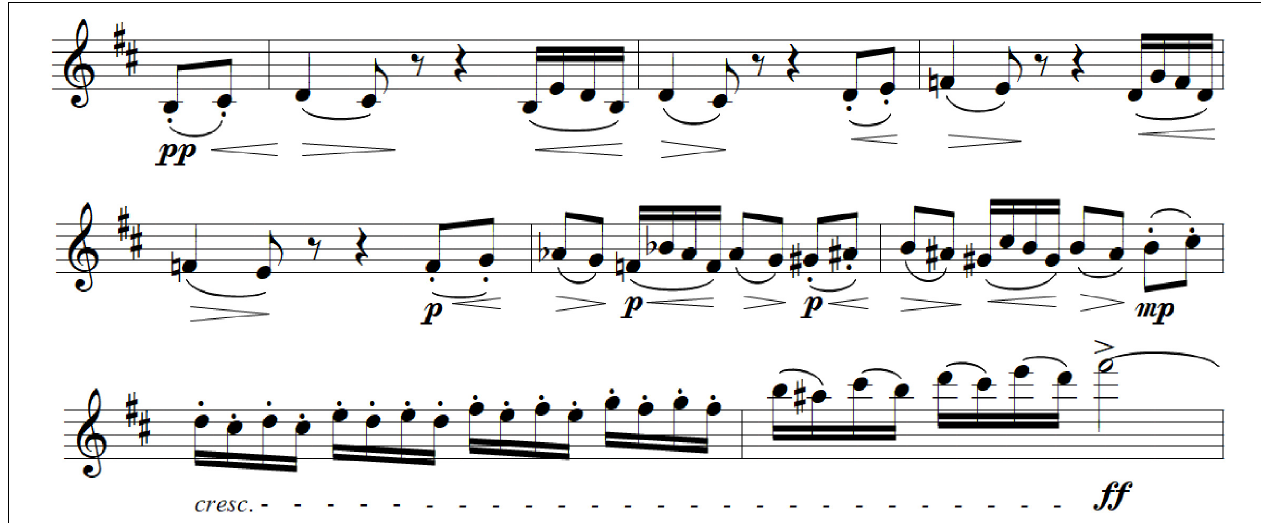
FIGURE 2 | Allegro non-troppo from the 1st movement, Tchaikovsky’s Pathétique Symphony, measures 30–38 (Violin I). Audio version, Musopen Orchestra, Supplementary Audio 2 .